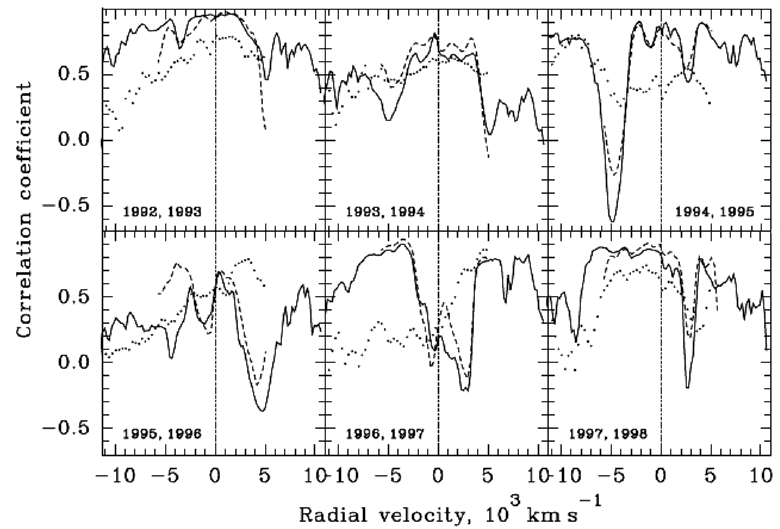
Fig. 3. The correlation of broad-line flux with continuum flux as a function of ve- locity for NGC 4151 in six separate observing seasons. The solid line shows correlation coefficients for H (cid:11) , the dashed line for H (cid:12) and the dots for He II (cid:21) 4686. Adapted from Sergeev et al.